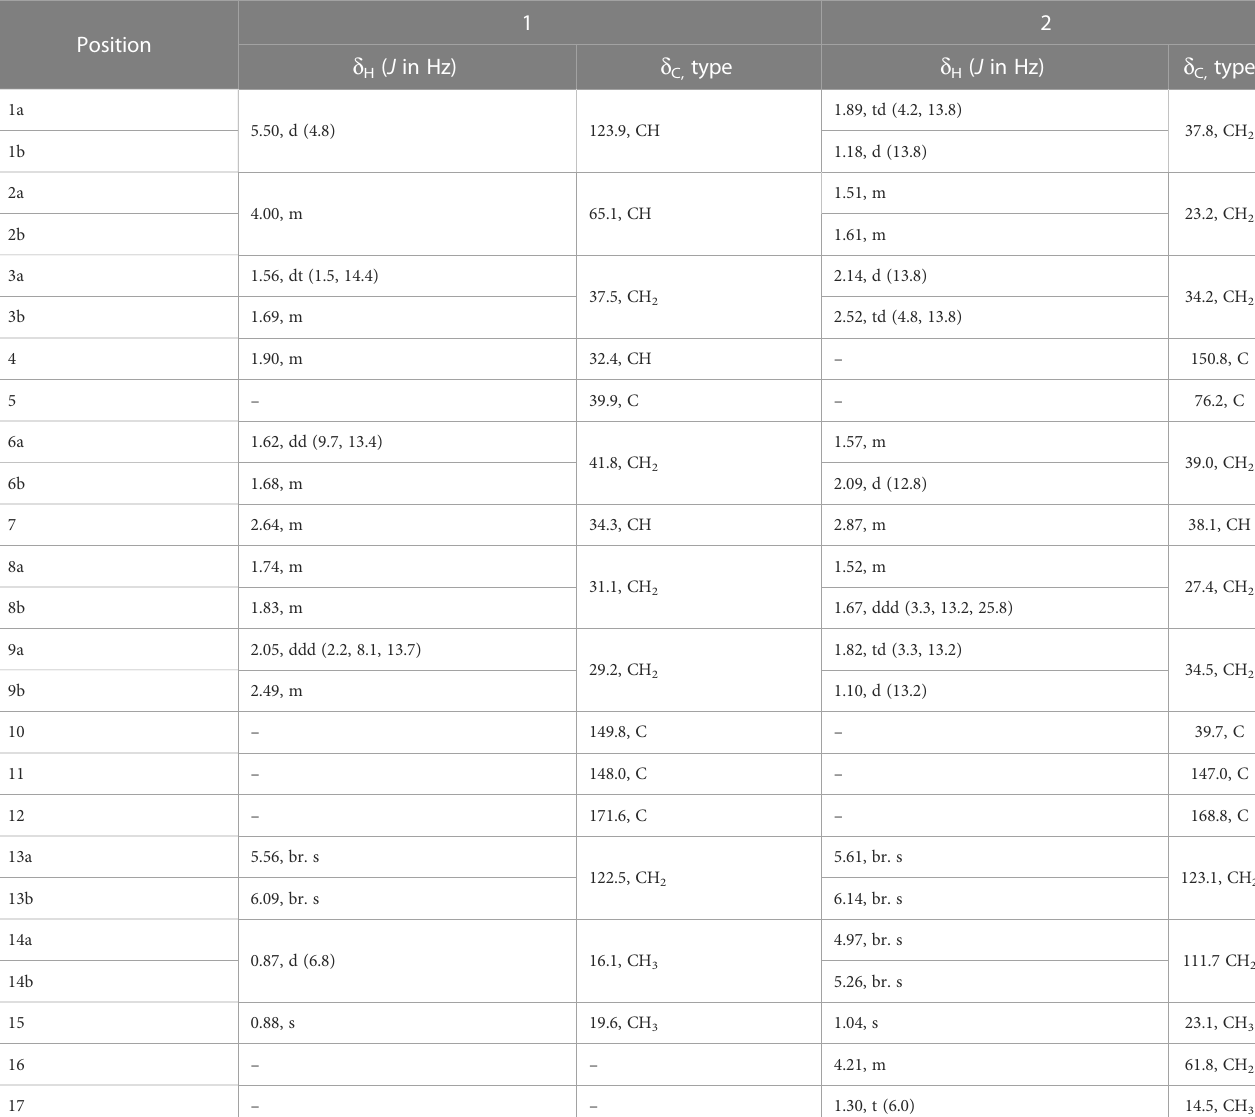
TABLE 1 1 H and 13 C NMR Data of Compounds 1 and 2 ( d in ppm, J in Hz, 600 MHz for 1H and 150 MHz for 13C, in Methanol-d4).